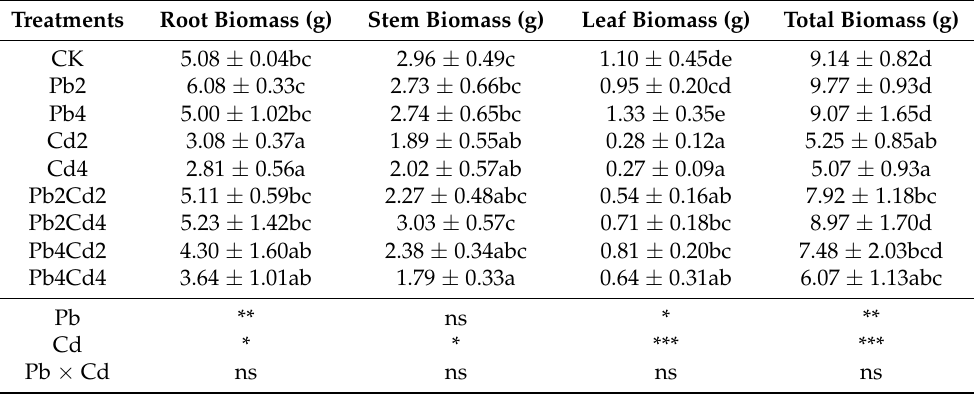
Table 3. Effects of individual and combined Pb and Cd stress on the biomass of different F. parvifolia tissues. The post hoc test used for the estimation of the significance level is the Duncan test. Different lowercase letters in the same column indicate significant differences at p < 0.05. Each value represents mean values ± SEs (n = 5). ns, p > 0.05; *, p < 0.05; **, p < 0.01; ***, p <